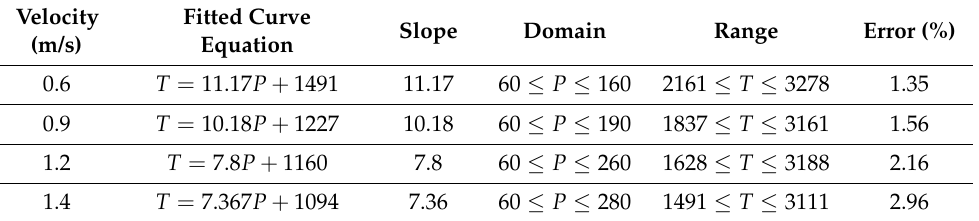
Table 5. Equations of fitted curves of laser power–temperature simulation results with a laser spot diameter of 80 µ m. In equations, T denotes the temperature (K) and P denotes the laser power (W).